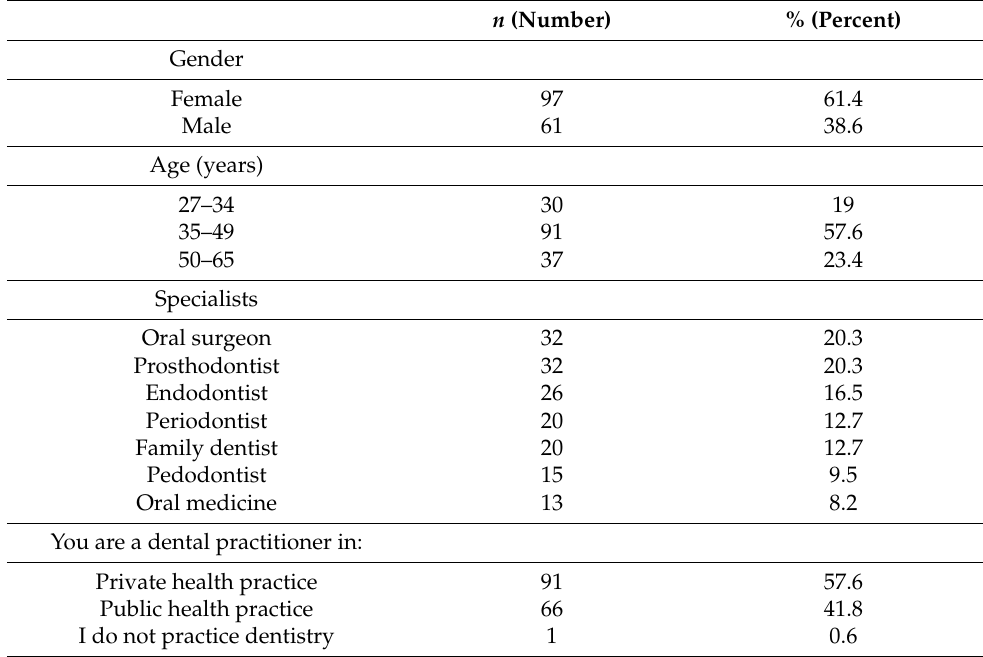
Table 1. The characteristics of the non-orthodontic specialists.